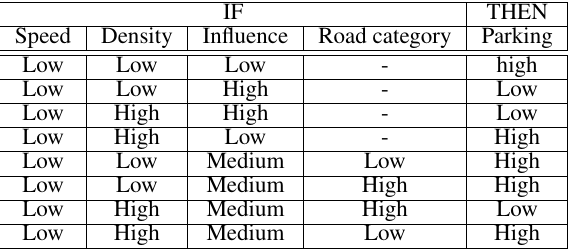
Table 3. If-then rules for vehicles in queues IF Table 4. If-then rules for vehicles not in